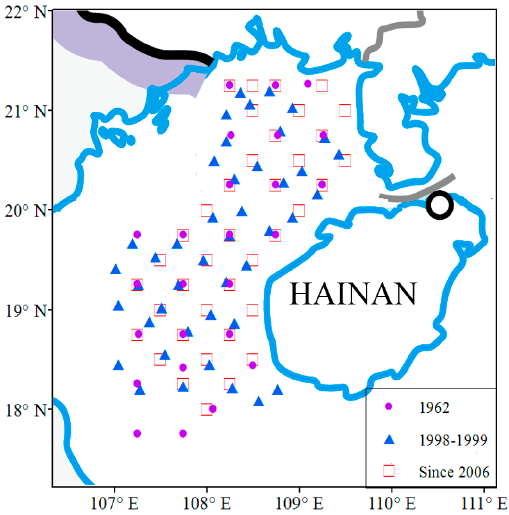
Figure 1. Map of Beibu Gulf and sampling stations of the fishery stock survey used in the present analysis (dots).